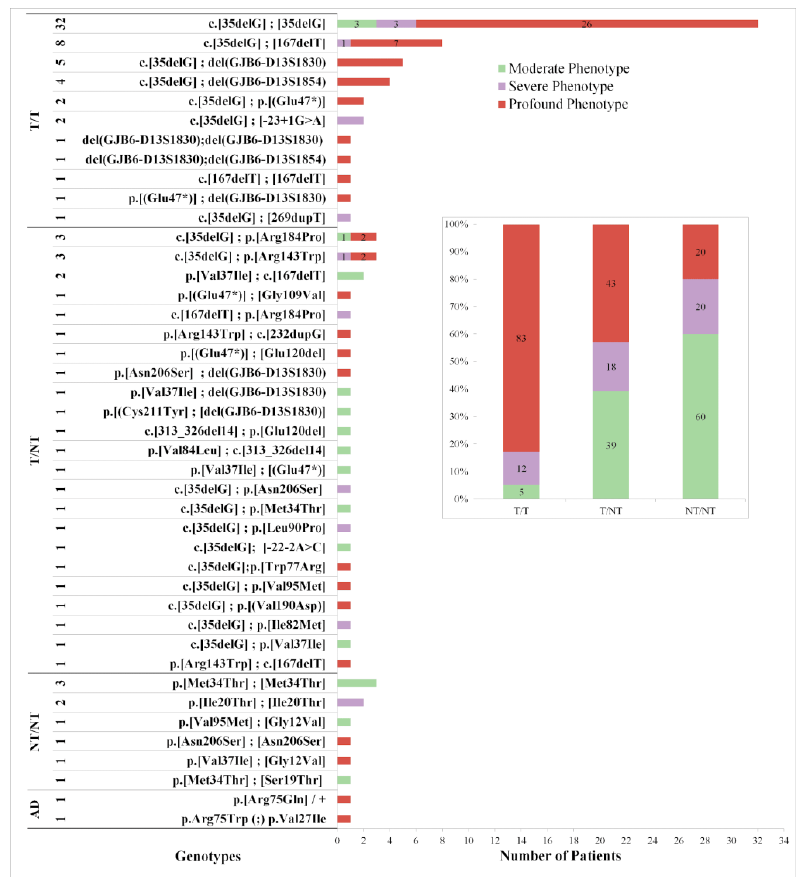
Figure 2. Distribution of Genotypes and Phenotypes of Patients. Moderate phenotype is shown in green, severe in violet and profound in red. The total number of each genotype is listed on the left together with its categorization: biallelic truncating (T / T), compound heterozygous truncating / non-truncating (T / NT) and biallelic non-truncating (NT / NT). Nomenclature was performed following HGVS recommendations; however, some variants keep the old annotation due to their common use in literature. In the inner box: Relative frequencies of the degree of HL in the three groups of genotypes. Biallelic T / T genotypes were mostly related to a worse degree of hearing impairment, since 83% of those patients exhibited profound HL. There were significant di ff erences among the three groups, with X 2 testing ( p <